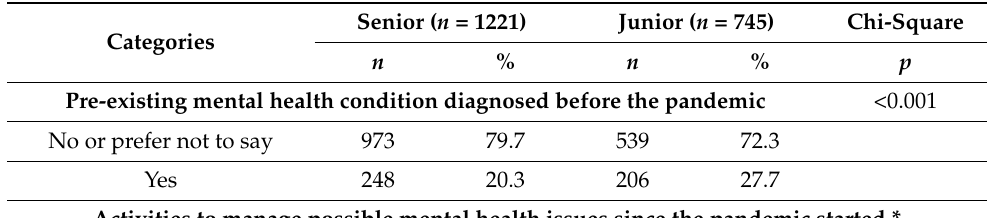
Table 2. Mental health, coping strategies, and help-seeking